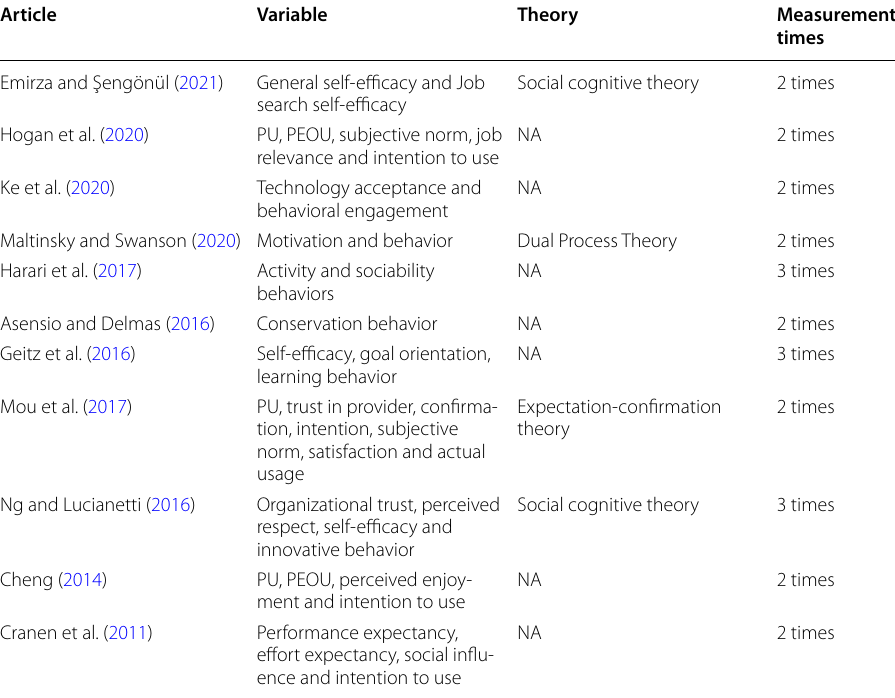
Table 2 A selective review of research on behavior change or attitude change Article Variable Theory Measurement